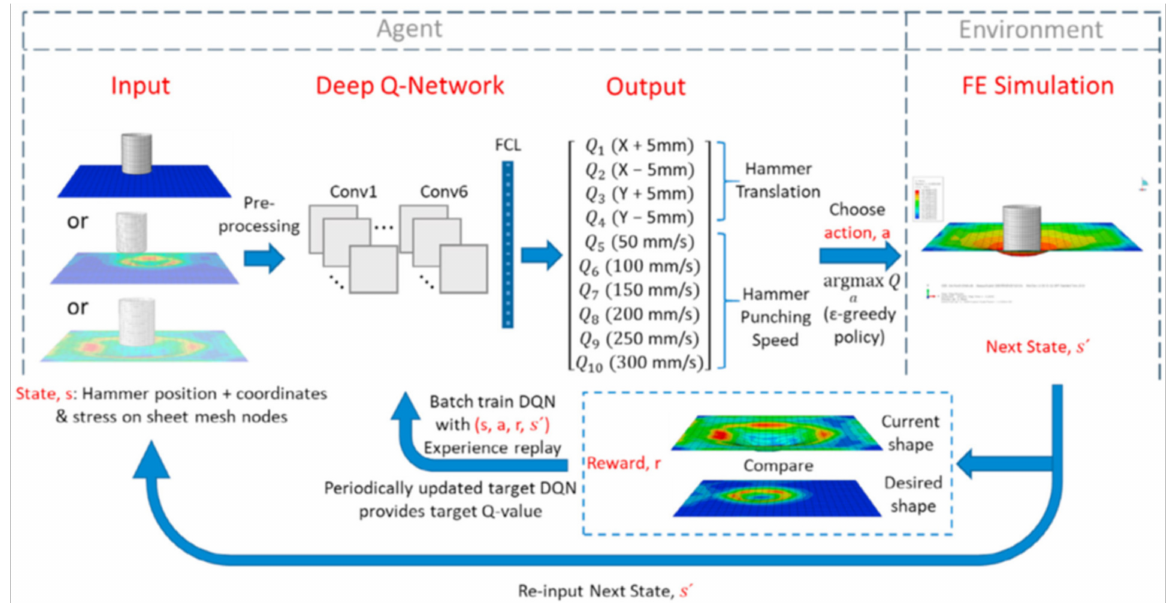
Figure 3. The overall learning algorithm diagram of the RL in free-form stamping of sheet-metals [34]. Table 1 summaries the main published intelligent optimization methods for stamping.